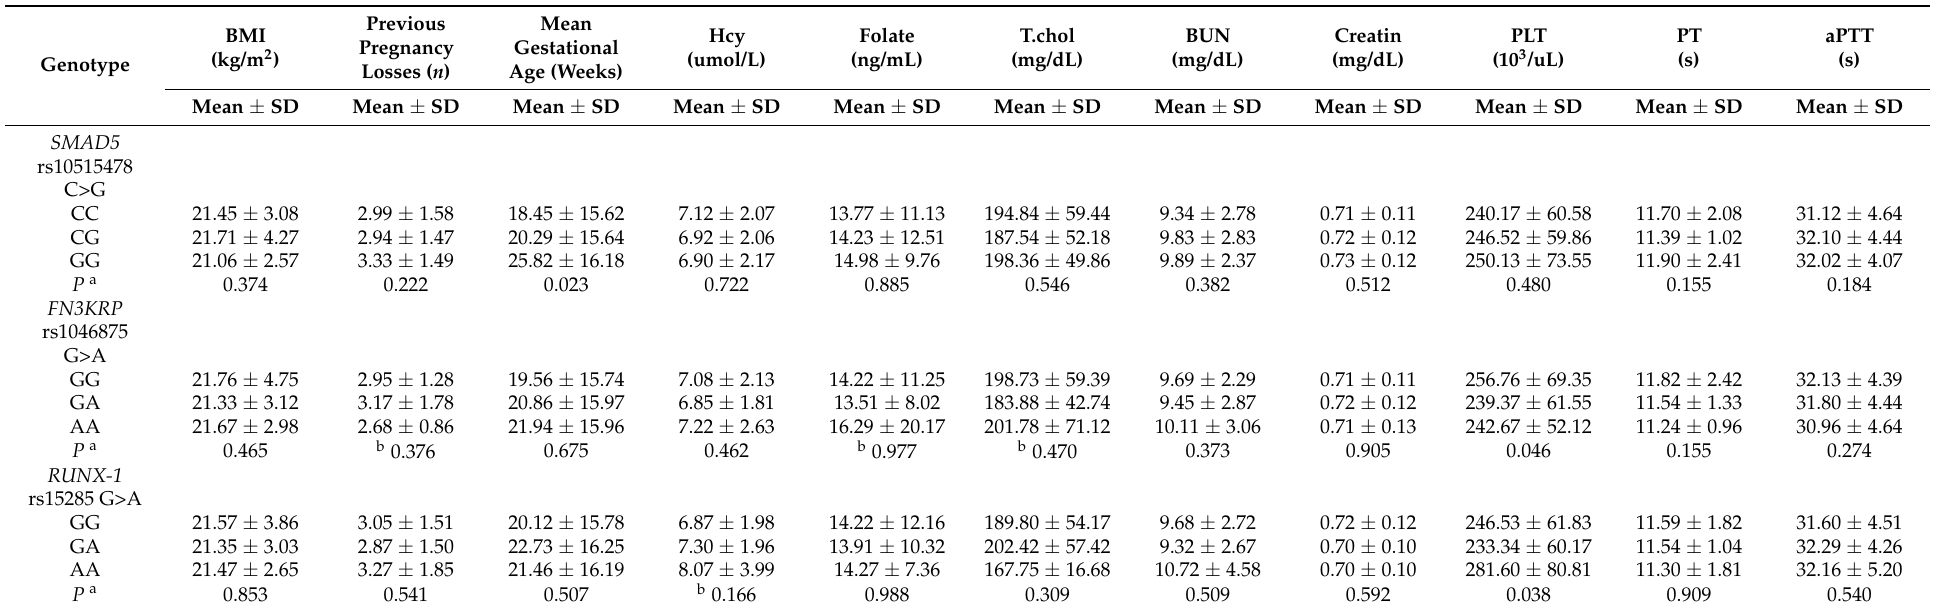
Table 5. Association between various clinical parameters and gene